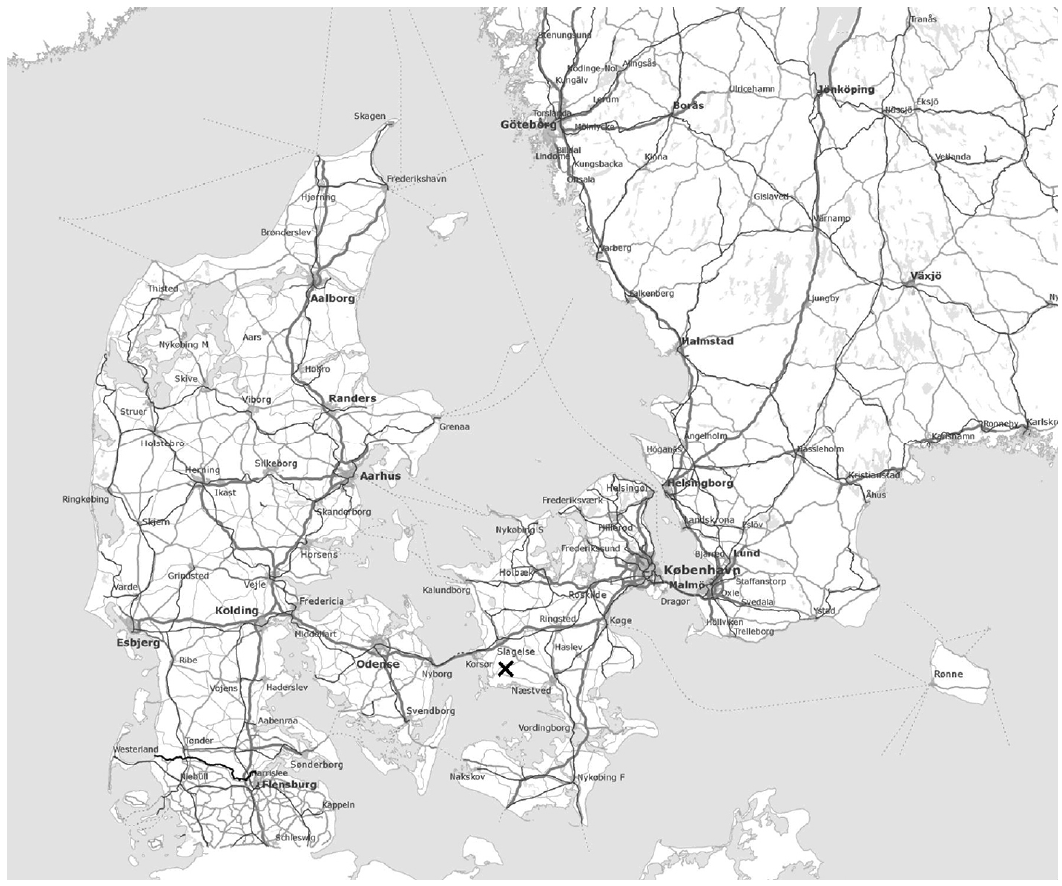
Figure 1. Map of Denmark and South Eastern Sweden. The X indicates the position of Høve.